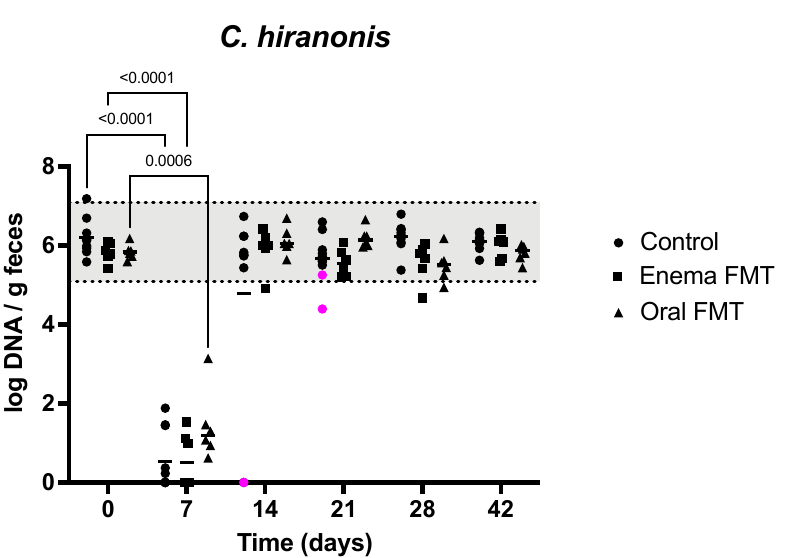
Figure 3. Dot plot graph representing the variation of fecal C. hiranonis abundance in control dogs, dogs receiving FMT by enema, and dogs receiving FMT orally over the 6-week duration of the study. Legend: The shaded area highlights the reference interval for the abundance of C. hiranonis in feces from dogs Dots represent individual values for each dog, bars denote median for the group and time point. Statistically significant pairwise comparisons are shown. The magenta dot identifies 2 dogs with identicallyvery low fecal abundances of C. hiranonis at day 14 that also had low secondary fecal bile acid concentrations at that same time (see Figure 2). The abundance remained below the reference interval in one dog at day 21.